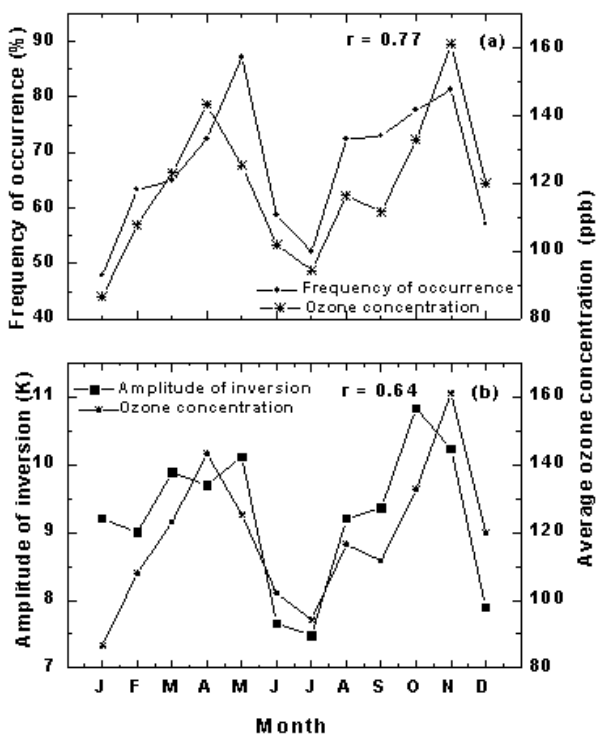
Fig. 8. Monthly mean variation in the ( a ) frequency of occurrence of temperature inversion (%) and that of ozone volume mixing ra- tios (ppb), averaged over the altitude range of 70–86km. A cor- relation coefficient in these parameters is found to be +0.77. ( b ) Amplitude of temperature inversion (k) and that of ozone volume mixing ratios (ppb), averaged over the altitude range of 70–86km. A correlation coefficient in these parameters is found to be +0.64. Both ozone volume mixing ratio and temperature data are obtained using HALOE during 1991–2001 over the Indian tropical region (0–30 ◦ N, 60–100 ◦